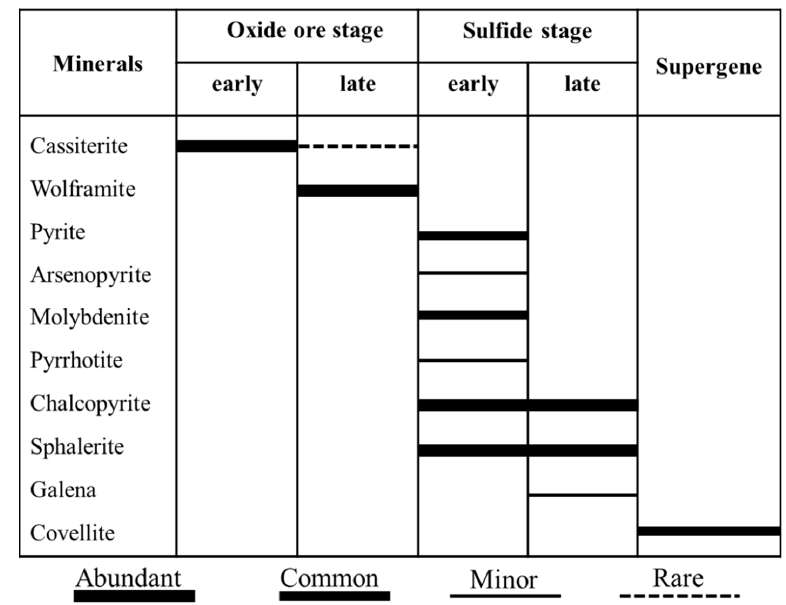
Figure 11. Paragenetic sequence of ore mineralization of the Tagu Sn–W deposit, southern Myanmar.